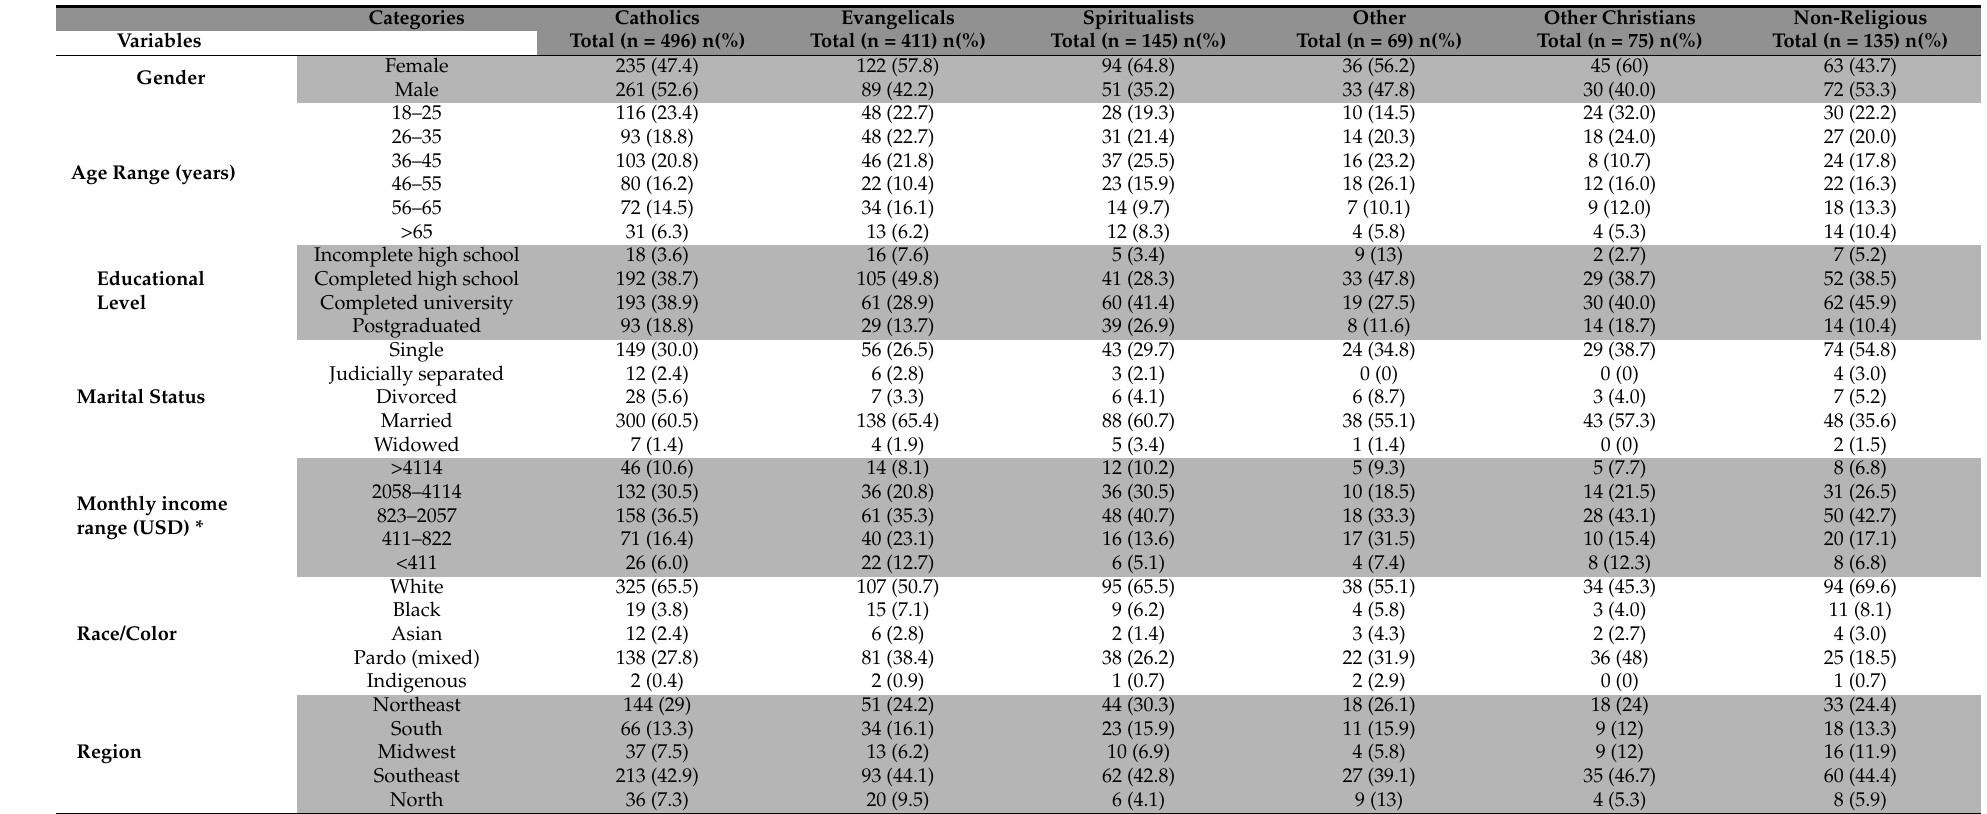
Table 1. Descriptive characteristics of the